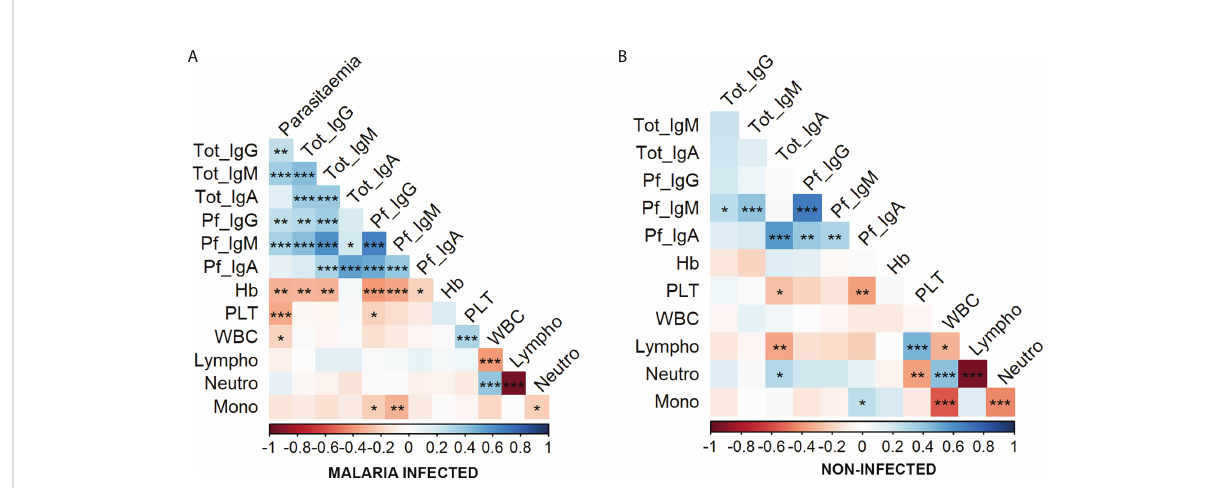
FIGURE 5 Correlation between parasitemia, immunoglobulins, and hematological parameters in malaria-infected and non-infected groups. Correlations were calculated by Spearman ’ s partial correlation test controlling for the age of individuals in the whole population (n = 176 as 25 individuals were discarded as they lacked hematological data, serum sample and/or were HIV+). The asterisks indicate the signi fi cant correlation between the variables on the axes. Positive correlations are marked in blue and negative correlations in red. *P ≤ 0.05; **P ≤ 0.01; ***P ≤ 0.001. (A) Correlations in the malaria-infected individuals including microscopic and submicroscopic infections. (B) Correlations in the non-infected